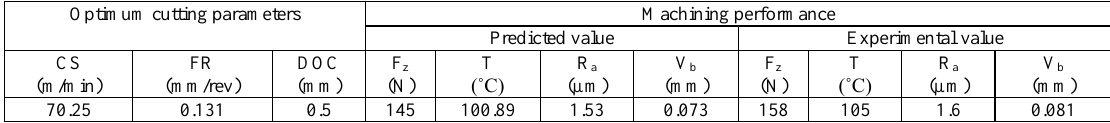
Table 8. The optimized and validation responses